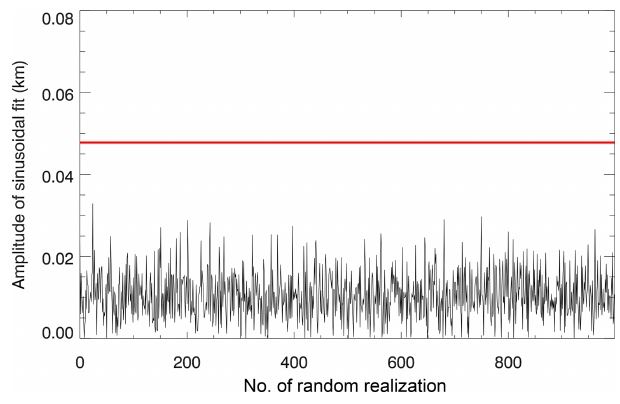
Figure 5. Illustration of the Monte Carlo significance test. The red line shows the amplitude of a sinusoidal fit to the extracted 27-day signature in SPH. The black line shows the fitted amplitudes to epoch-averaged SPH anomalies for 1000 randomly chosen epoch ensembles. See text for more detailed